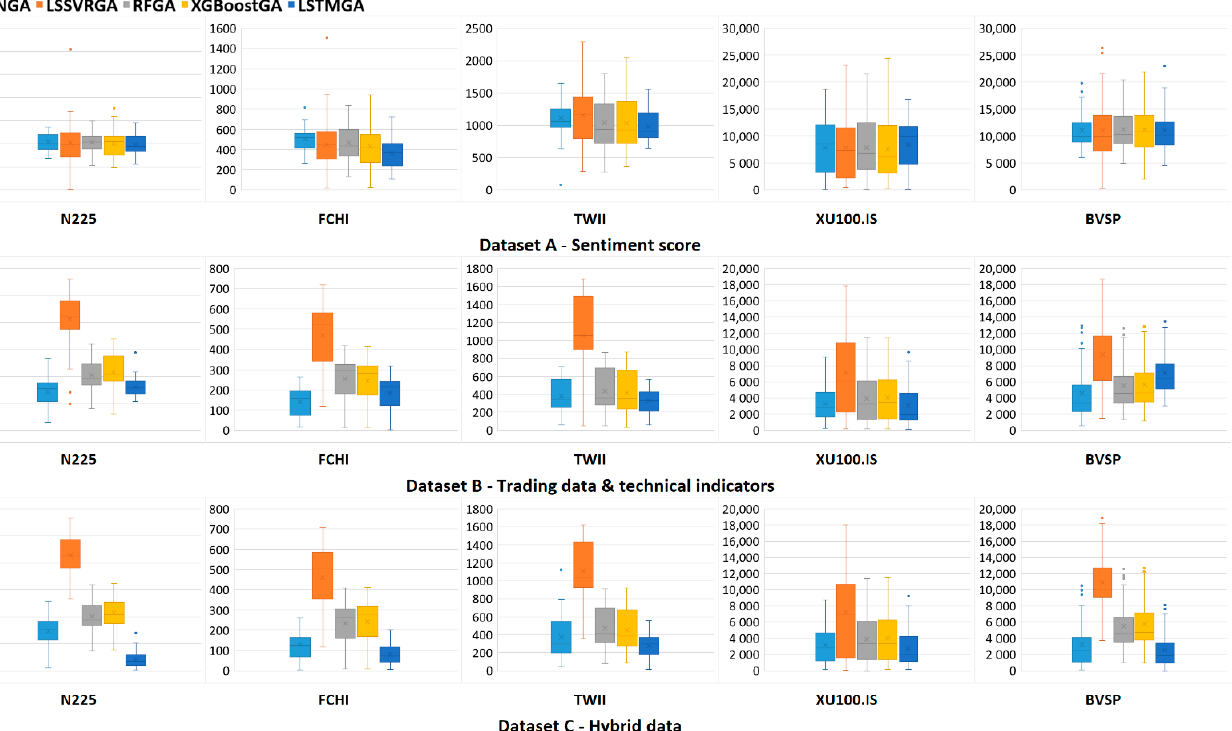
Figure 8. Boxplots in terms of absolute errors for forecasting models with three datasets of stock market indices.